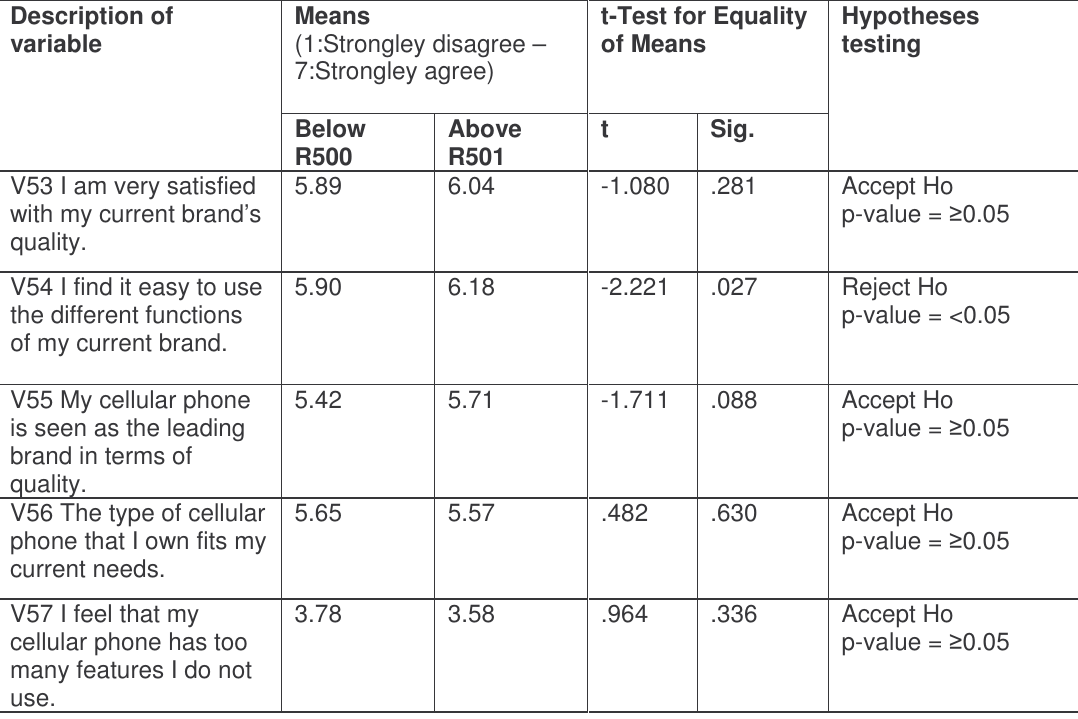
Means t-Test for Equality Hypotheses (1:Strongley disagree – of Means 7:Strongley agree) Below Above t Sig. R500 R501